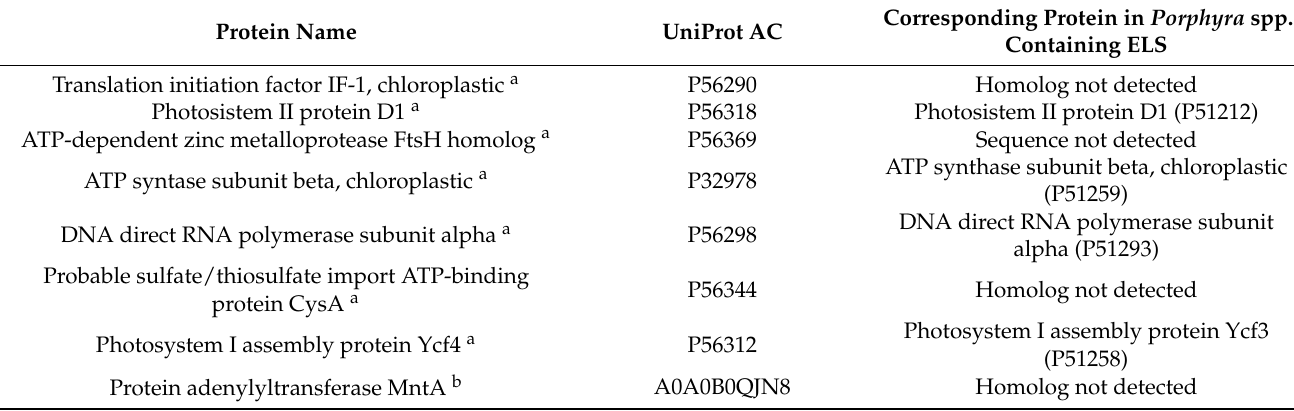
Table 2. List of C. vulgaris and AFA reviewed proteins containing